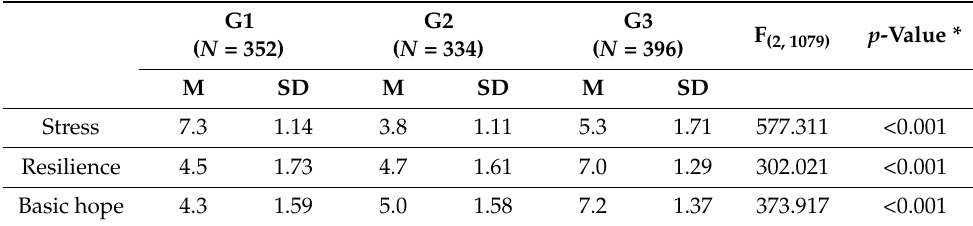
Table 4. Analysis of intergroup differences in the mean levels of selected psychological